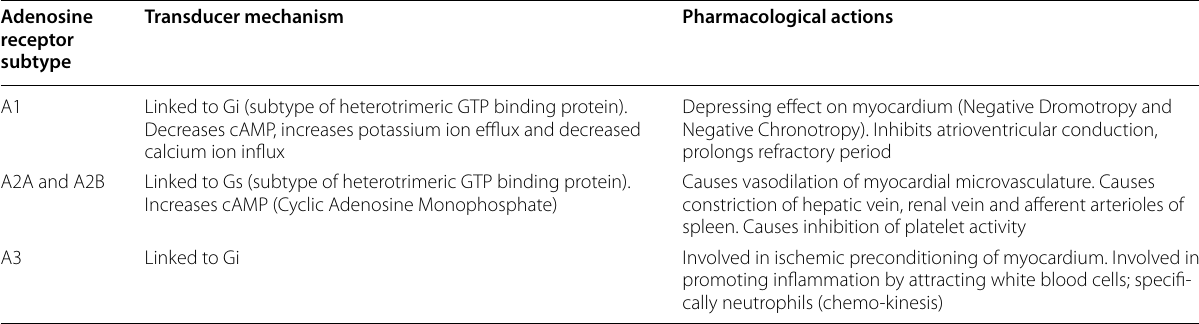
Table 1 Various adenosine receptors, their transducer pathways, location and actions